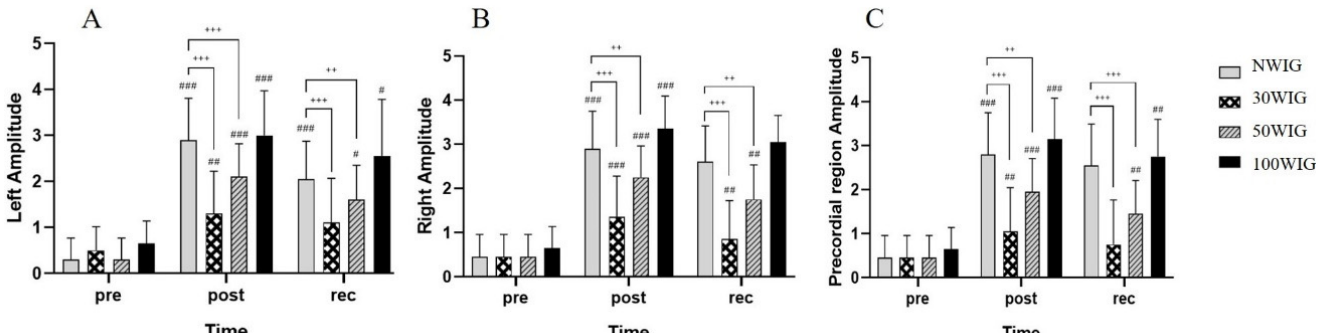
Figure 3. Comparison of amplitude in the left subclavian vein ( A ), right subclavian vein ( B ) and the precordial region ( C ). Following ANCOVA, Bonferroni post hoc analysis was conducted to specify protocol effect. NWIG, no-water-intake group; 30WIG, 30%-water-intake group; 50WIG, 50%-water-intake group; 100WIG, 100%-water-intake group. The data are represented as mean ± SD. *, ** and *** represent p ≤ 0.05, p ≤ 0.01, and p ≤ 0.001, respectively, when compared to NWIG at post-dive (post). # , ## , and ### represent p ≤ 0.05, p ≤ 0.01, and p ≤ 0.001, respectively, when compared to NWIG at 30 min into recovery time (rec).